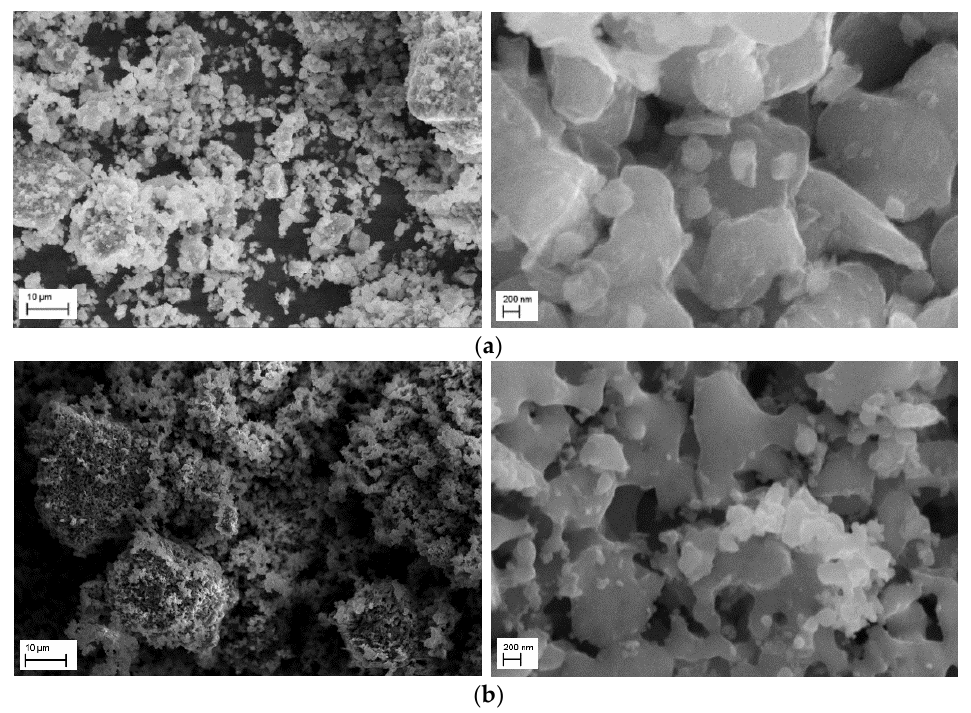
Figure 2. SEM images of the as-prepared ( a ) Li 3 V 2 (PO 4 ) 3 (92.5 wt%)/Li 3 PO 4 (7.5 wt%) and ( b ) Li 3 V 2 (PO 4 ) 3 (86 wt%)/Li 3 PO 4 (14 wt%) composites surface at different magnifications.